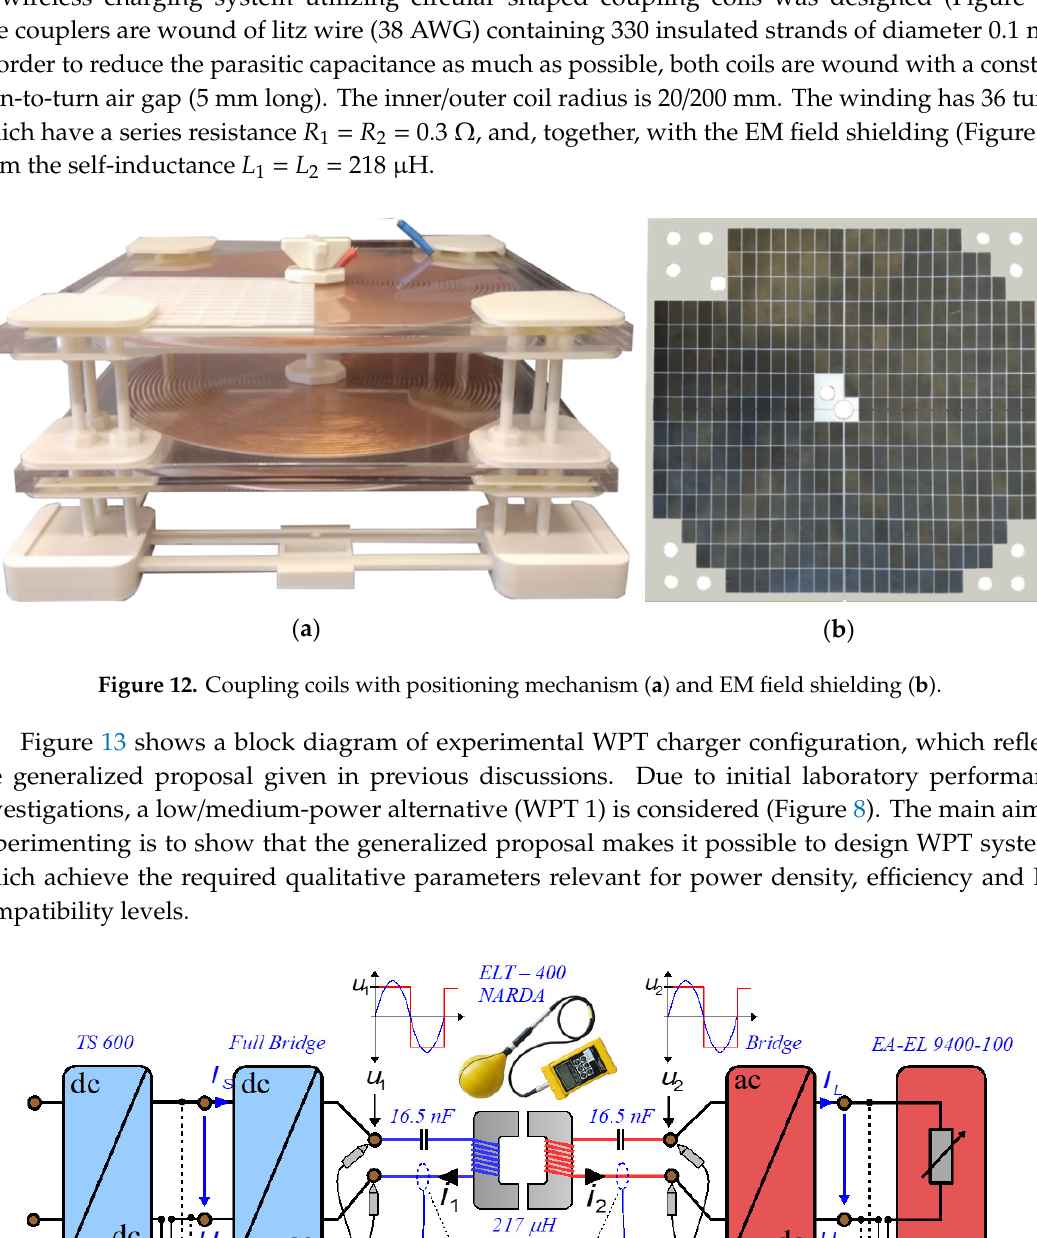
Figure 13. Schematic diagram of laboratory wiring.